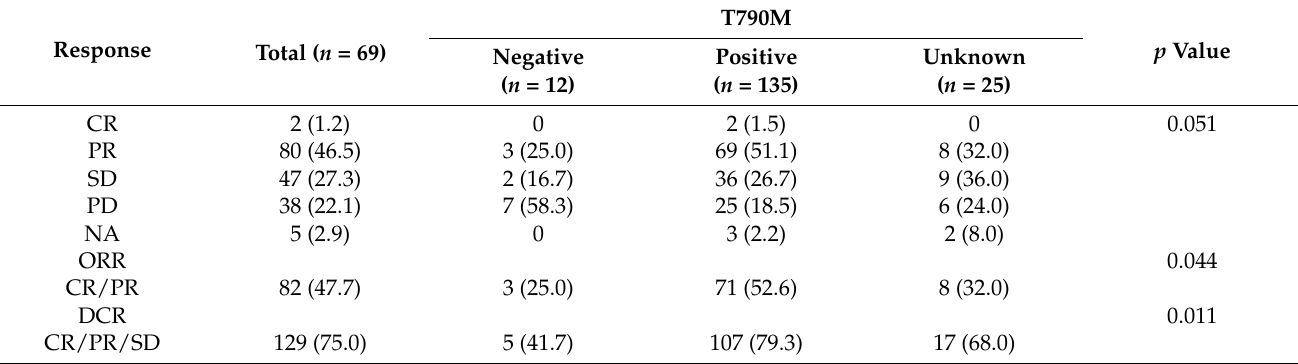
Table 2. Tumor base response of osimertinib based on T790M status.